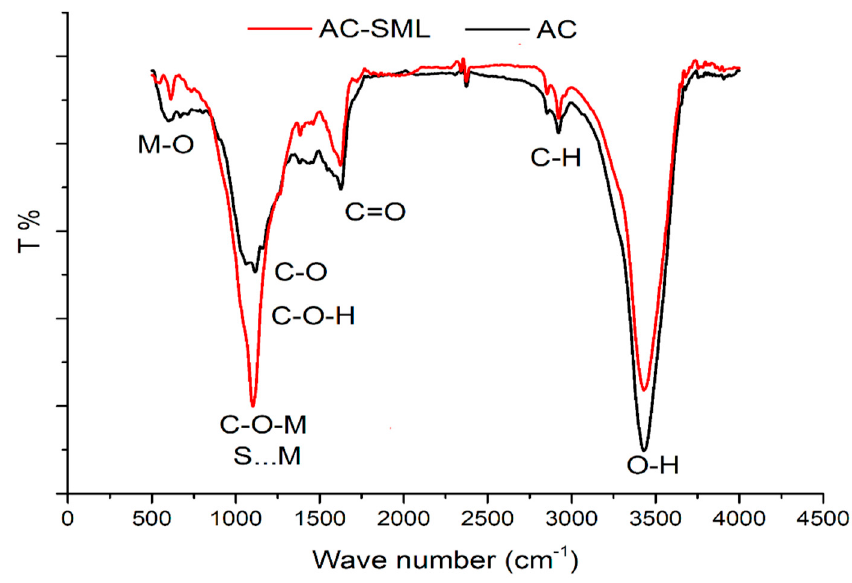
Figure 1. FTIR spectroscopy of pomegranate peel AC and AC-SML.